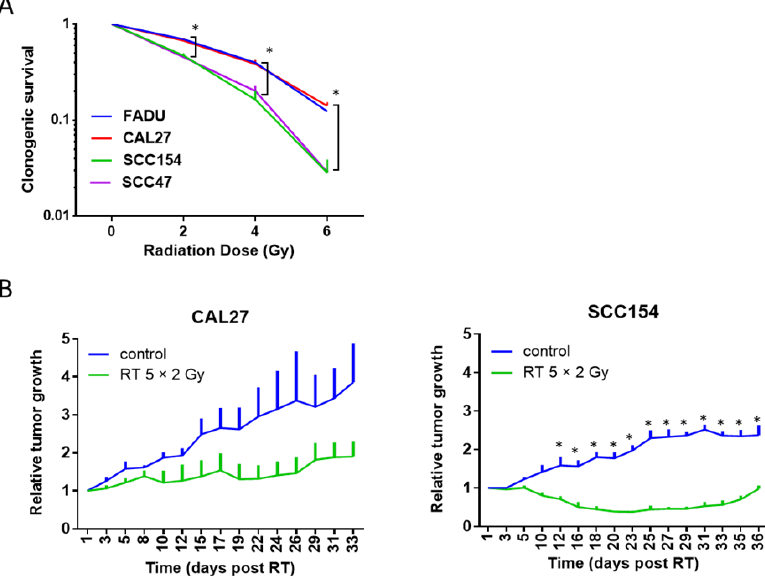
Figure 3. RT response of HPV-negative and HPV-positive cells assessed by clonogenic assays ( A ) and in vivo xenograft models ( B ). ( A ) HPV-negative (FADU and CAL27) and HPV-positive (SCC154 and SCC47) cells were irradiated with the indicated RT doses. Clonogenic cell survival is shown as the mean clonogenic survival fraction ± s.e.m., n = 3 . ( B ) Relative tumor volume curves of HPV-negative CAL27 and HPV-positive SCC154 xenografts treated with vehicle with RT (5 × 2 Gy). Relative tumor growth curves were normalized to the tumor volume at the start of treatment day 1. Day 1 indicates the start of RT treatment. Data are presented as mean ± s.e.m., n = 3. ( A , B ) * p -values < 0.05 were determined by two-way ANOVA with Bonferroni correction for multiple